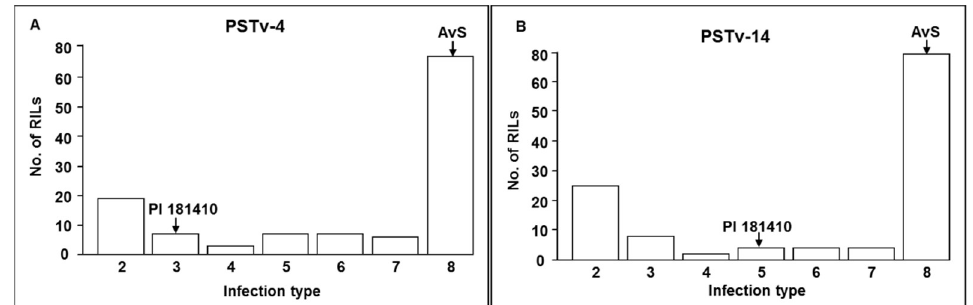
Figure 1. The distribution of infection types (ITs) among F 7 recombinant inbred lines (RILs) derived from the cross AvS × PI 181410 tested in greenhouse using races ( A ) PSTv-4 and ( B ) PSTv-14 of Puccinia striiformis f. sp. tritici .